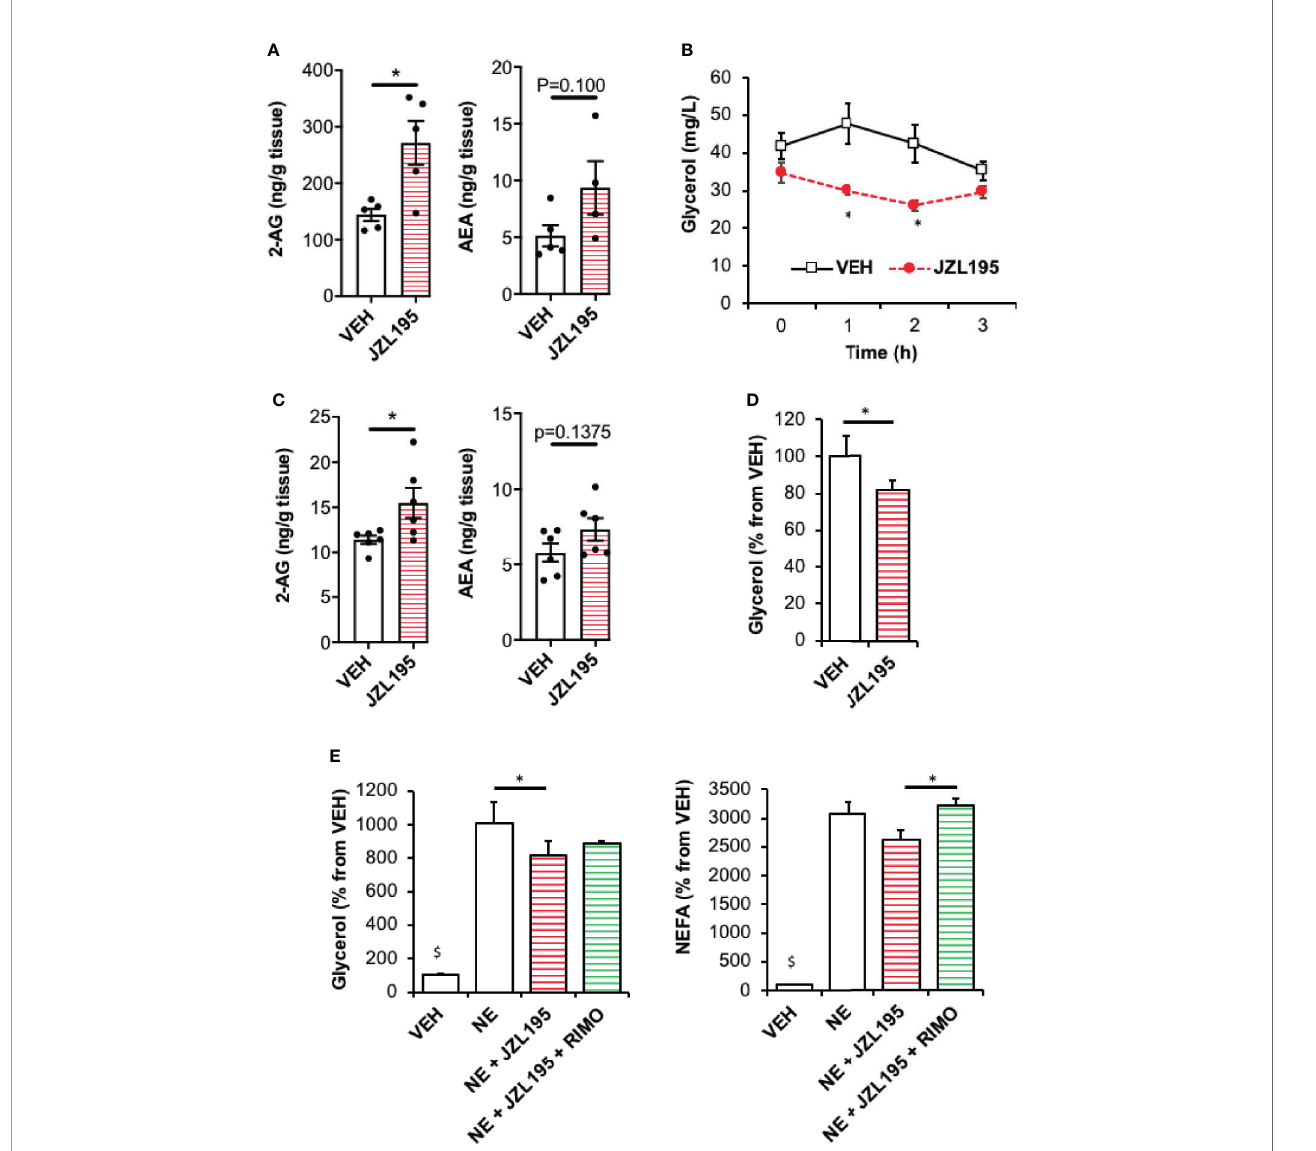
FIGURE 1 | Elevation of endocannabinoid tone in WAT by JZL195 decreases lipolysis. (A) 2-AG and AEA levels in epididymal WAT collected from mice 3 hours after an intraperitoneal injection of vehicle (VEH) or JZL195 (20 mg/kg); n=5/group. (B) Kinetic of plasma glycerol (0, 1h, 2h and 3h) in mice after an intraperitoneal injection of VEH or JZL195 (20 mg/kg); n=5/group. (C) 2-AG and AEA levels measured in rat WAT explants after a 3-hour incubation with VEH or JZL195 (10 µM); n=6/group. (D) Basal glycerol production by WAT explants treated 3 hours with VEH or JZL195 (10 µM). Explants were treated in triplicate and experiments repeated on 3 different rats (n=3/group). (E) Glycerol and non-esteri fi ed fatty acids (NEFA) production by rat WAT explants pre-incubated 3 hours with VEH or JZL195 (10 µM) and treated 1 additional hour with VEH, JZL195 or JZL195+Rimonabant (RIMO, 1 µM) in the presence of norepinephrine (NE, 1 µM). Explants were treated in triplicate and experiments repeated on 3 different rats (n=3/group). $ p < 0.001 VEH vs other treatments. Results are expressed as mean ± SEM. *p <